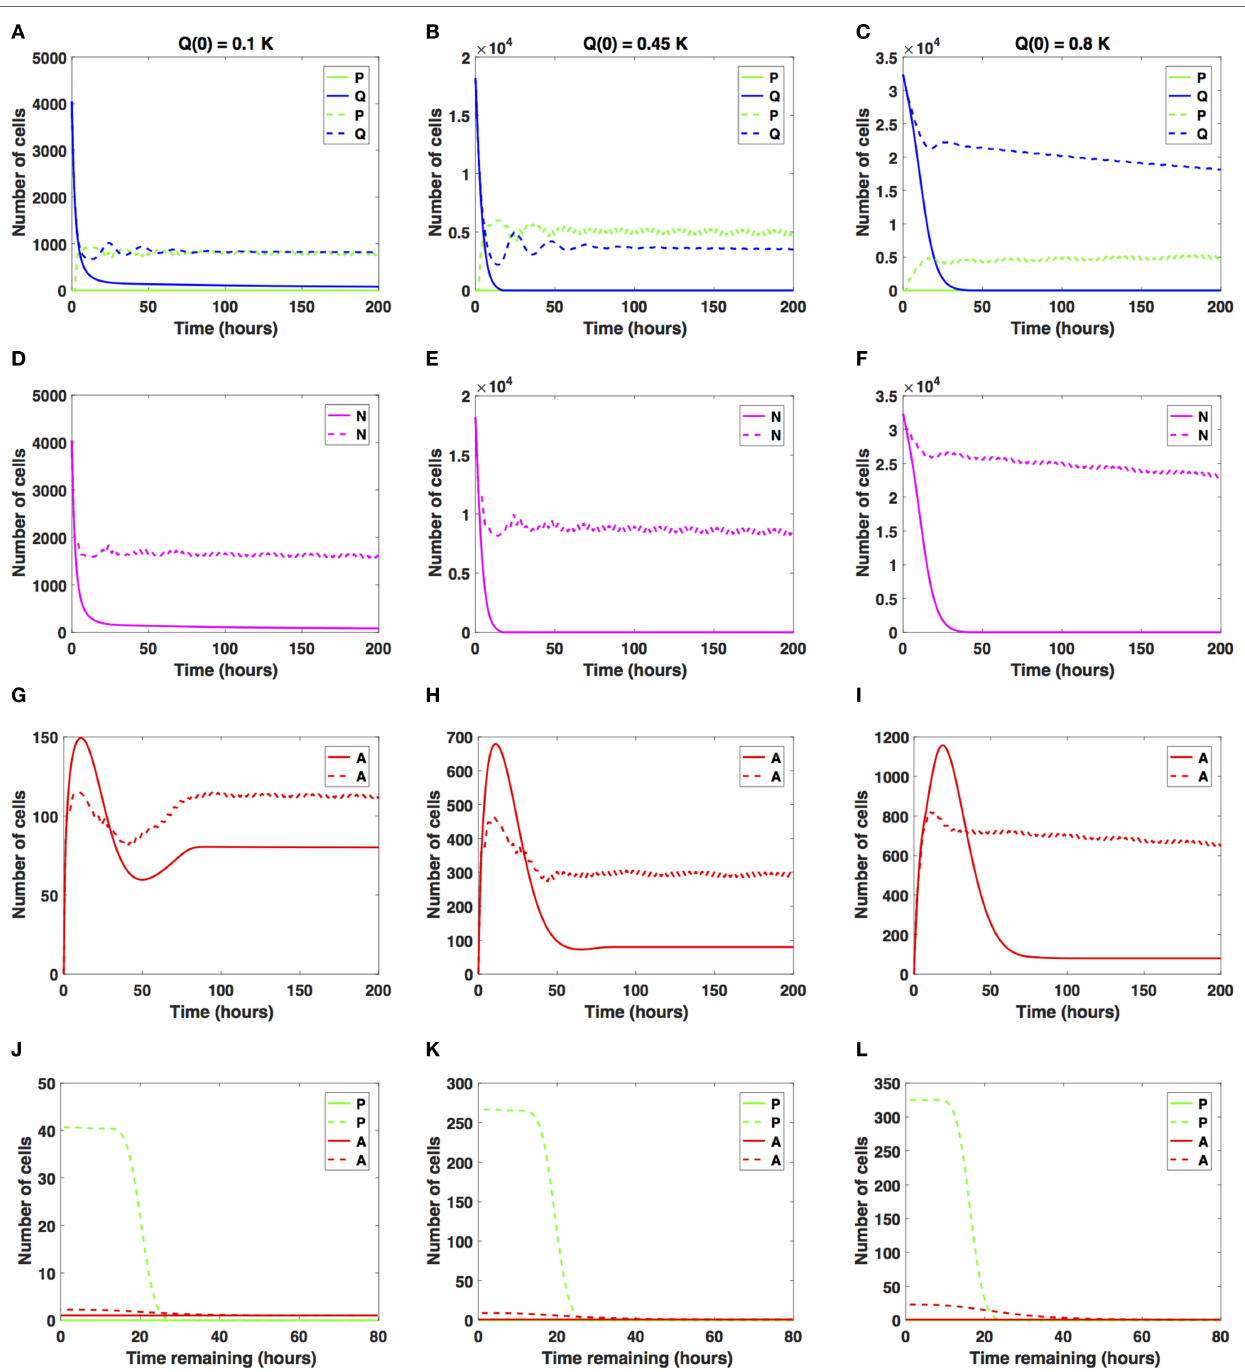
Frontiers in Oncology |